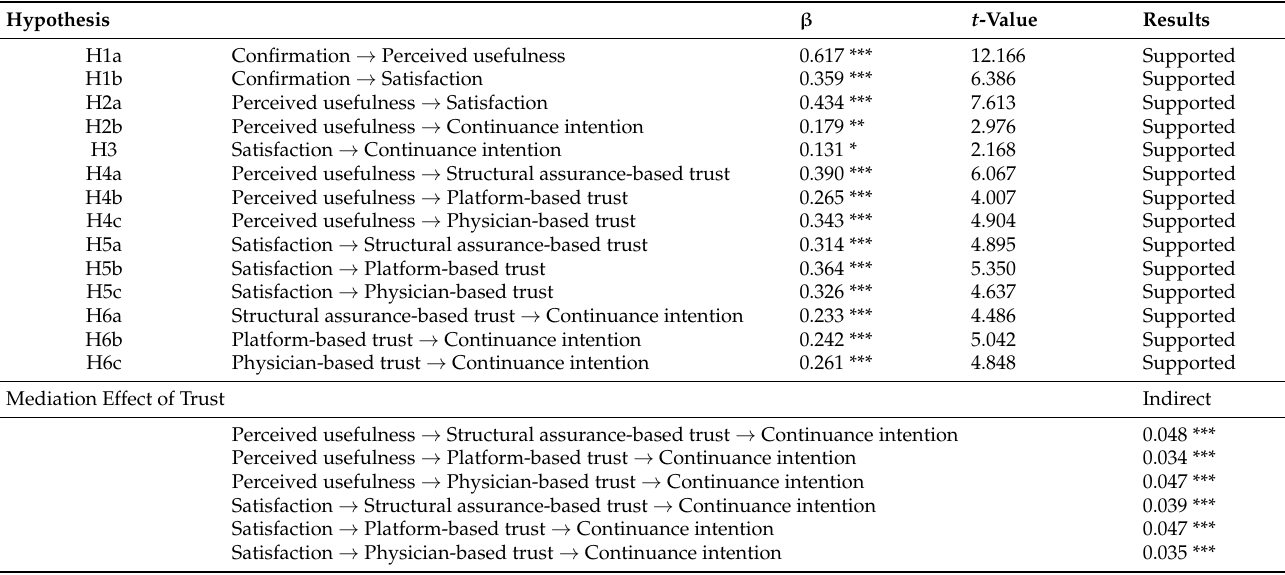
Table 4. Results of hypothesis testing and mediation effects.